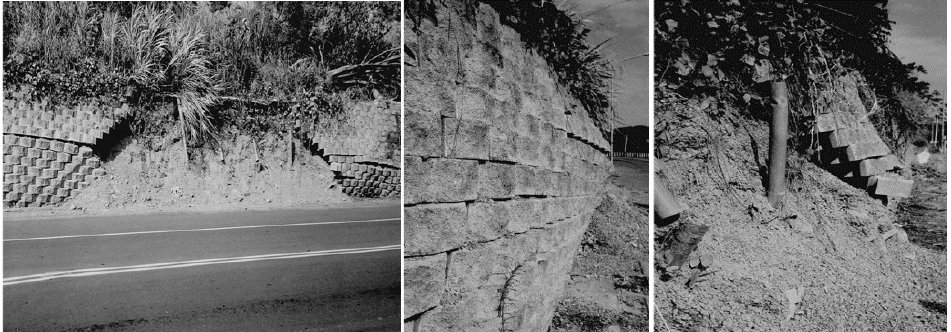
Figure 2. Failure case of reinforced soil retaining walls under earthquake action [8].